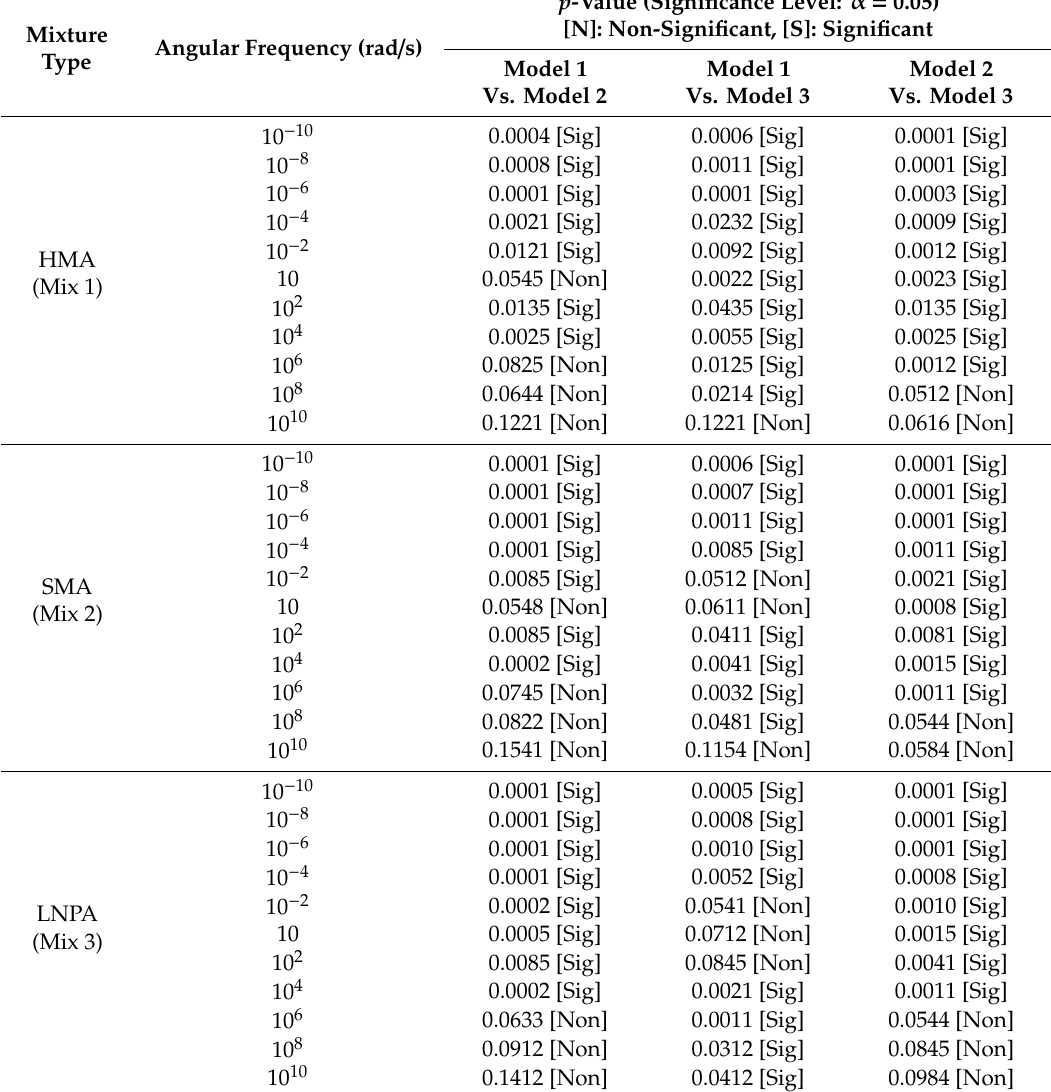
Table 4. Results of t -test for δ ( ω )